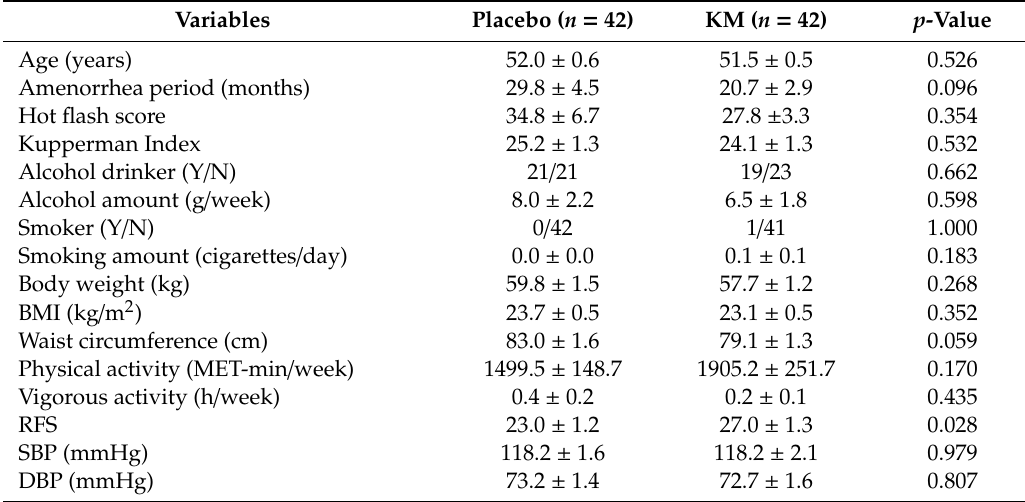
Table 1. Baseline characteristics of subjects in the intention-to-treat